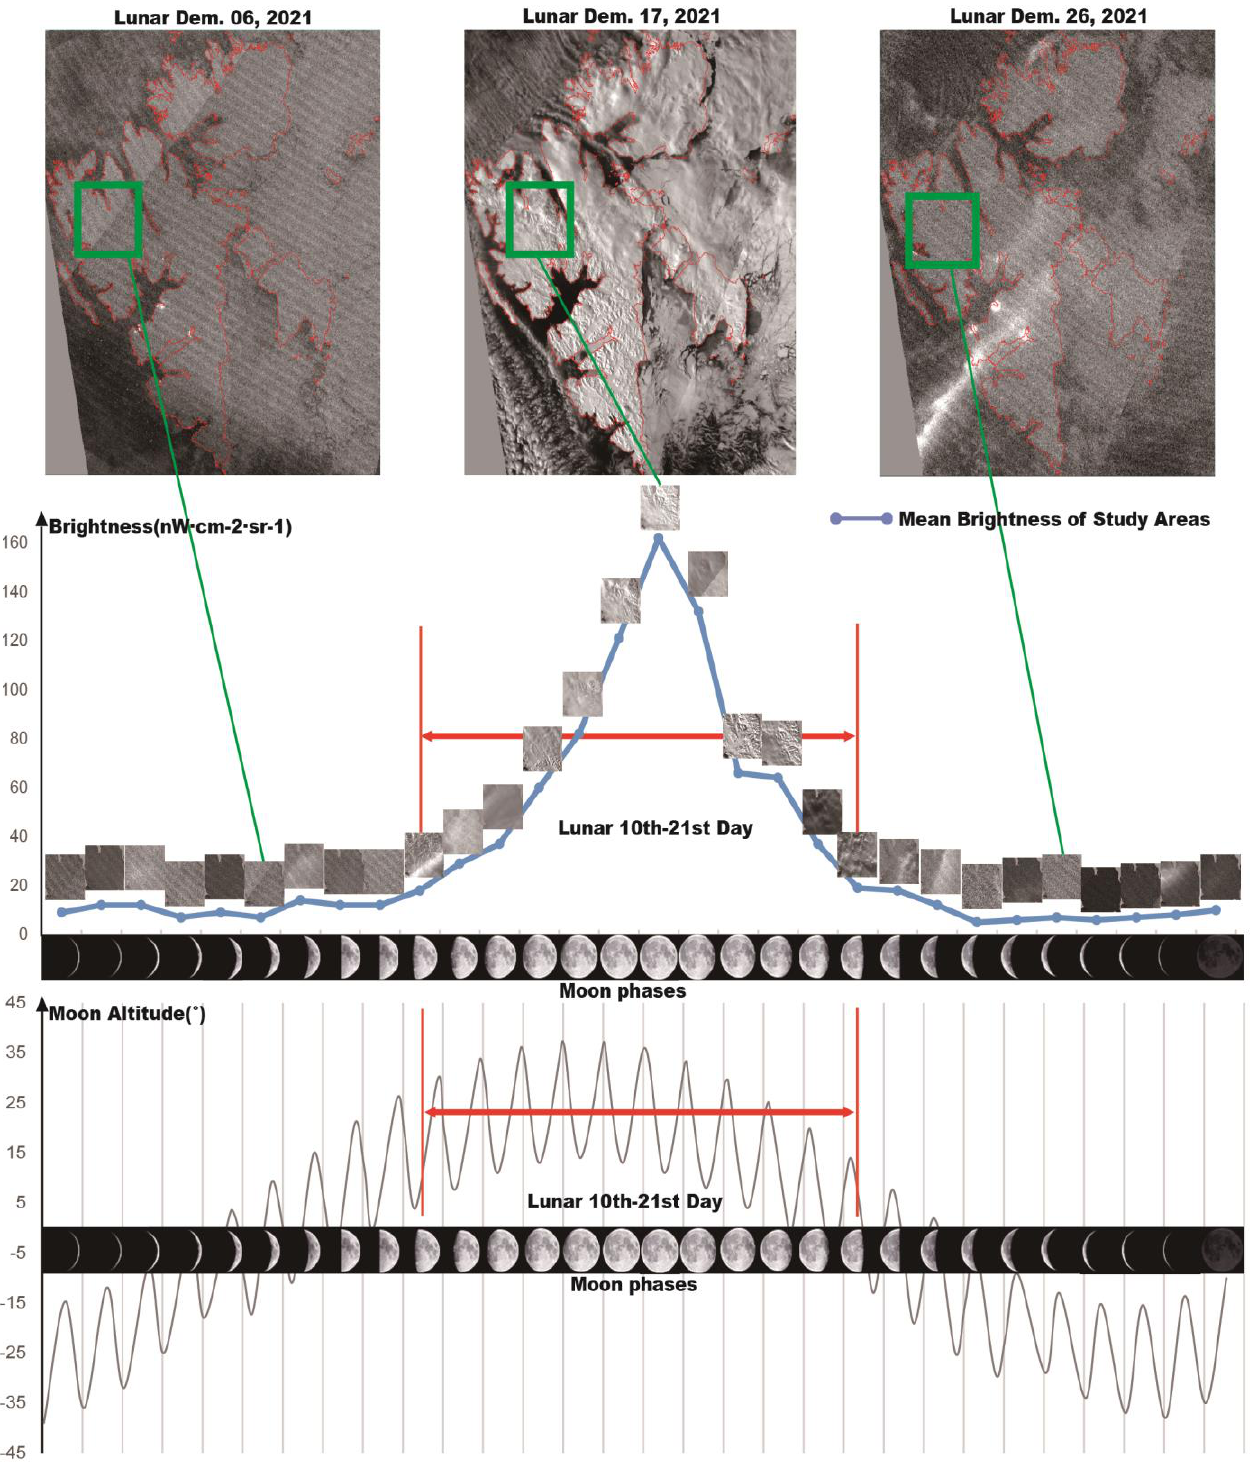
Figure 5. The brightness values and characteristics of moonlight remote sensing data during an en- tire lunar month. lunar